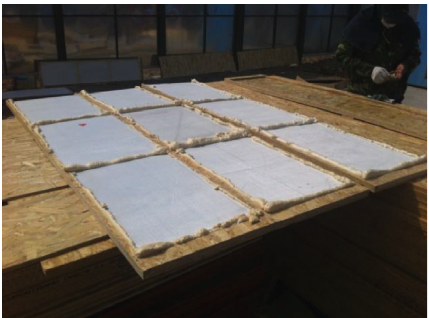
Figure 6: Reverse install integrated building insulation envelope technique (source: authors’ own